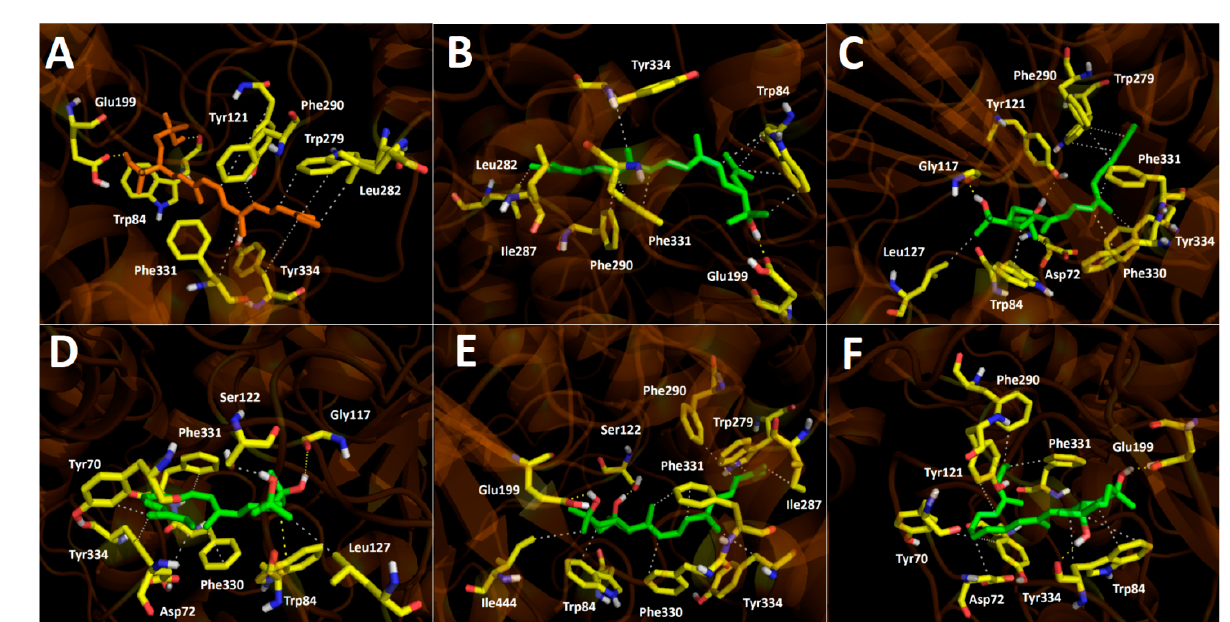
Figure 9. Predicted binding mode and predicted intermolecular interactions of different fragments (Figure 8) in the catalytic site of acetylcholinesterase; ( A ) fragment M 1 in the catalytic site ( B ) fragment M 2 in the catalytic site; ( C ) fragment M 3 in the catalytic site; ( D ) fragment M 4 in the catalytic site; ( E ) fragment M 5 in the catalytic site; ( F ) fragment M 6 in the catalytic site.